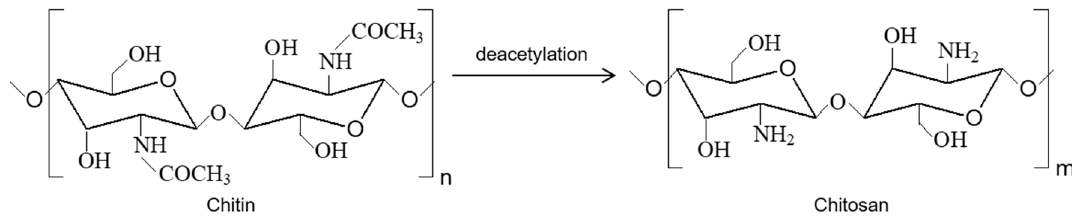
Figure 8. Deacetylation of chitin to chitosan.